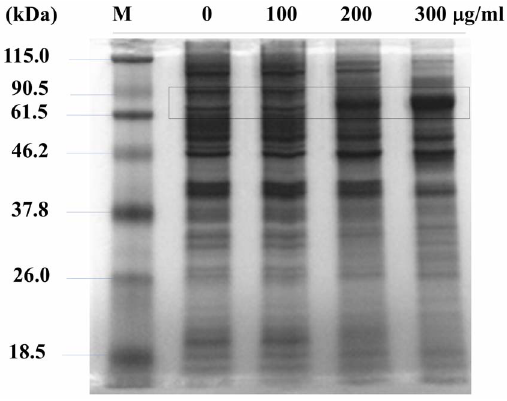
Figure 6. SDS-PAGE analysis for total cellular proteins. Total proteins in cells treated with or without the MOL extract were measured. Equal amounts of total proteins (20 m g) were separated on a 10% SDS polyacrylamide gel, stained with Comassie brilliant blue, and destained. The box highlights the molecular weight region of interest.